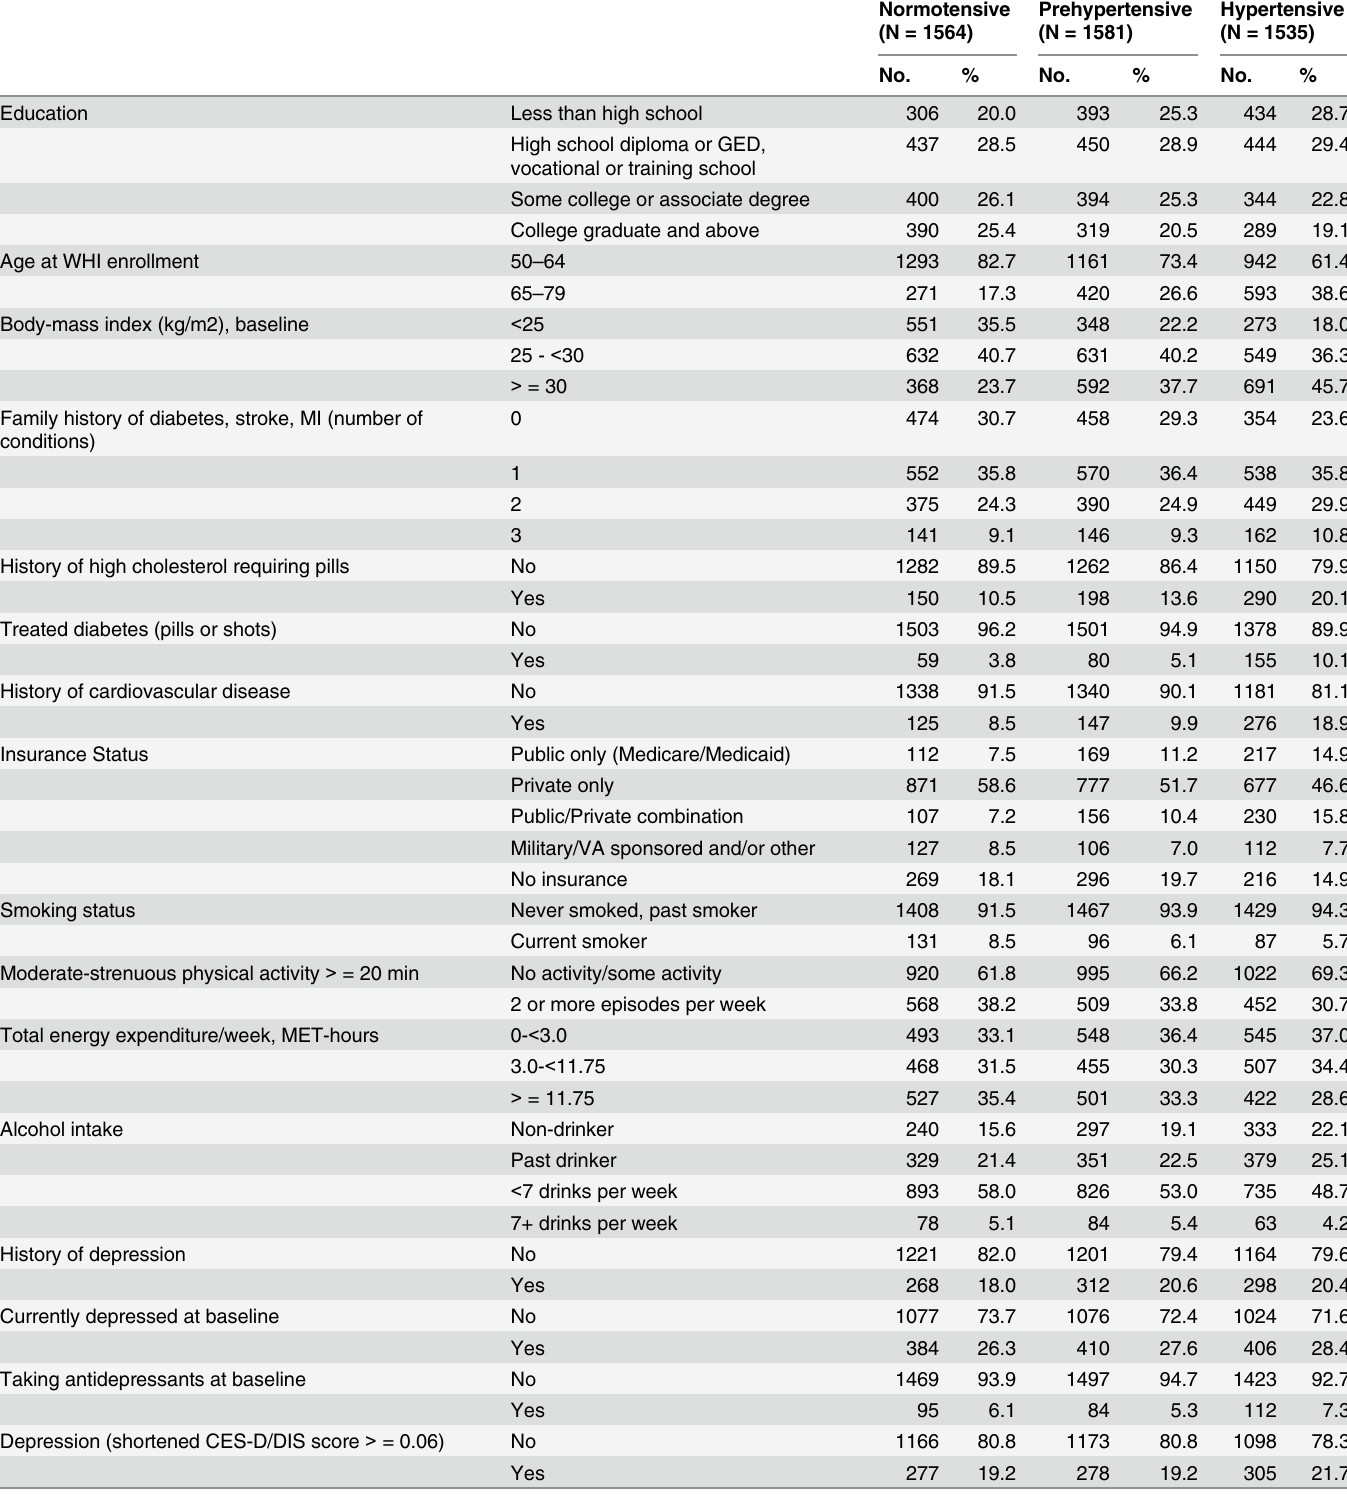
Table 1. Baseline Characteristics of Hispanic Women in the WHI Cohorts, by Baseline Hypertension